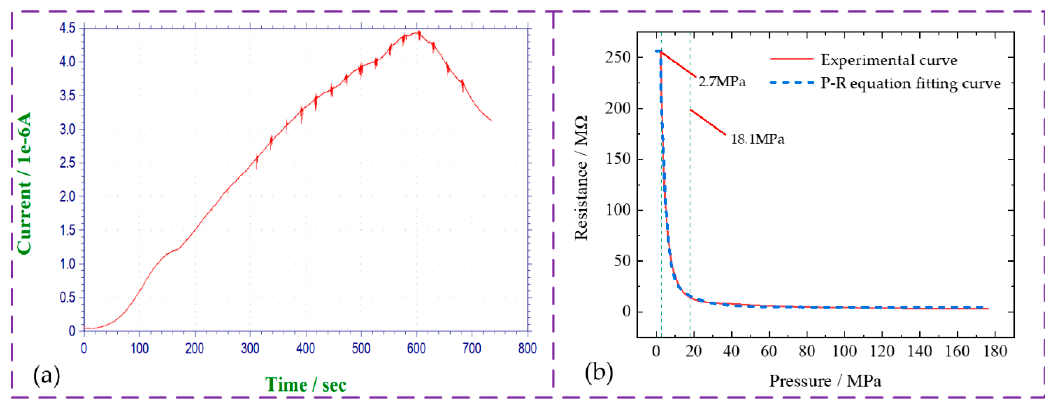
Figure 11. Relationship between pressure and ceramic conductivity: ( a ) the change of ceramic current in static pressure experiment; ( b ) the relationship between ceramic dielectric pressure and resistance.